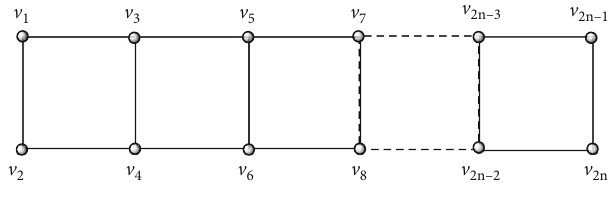
Figure 3: Ladder graph L